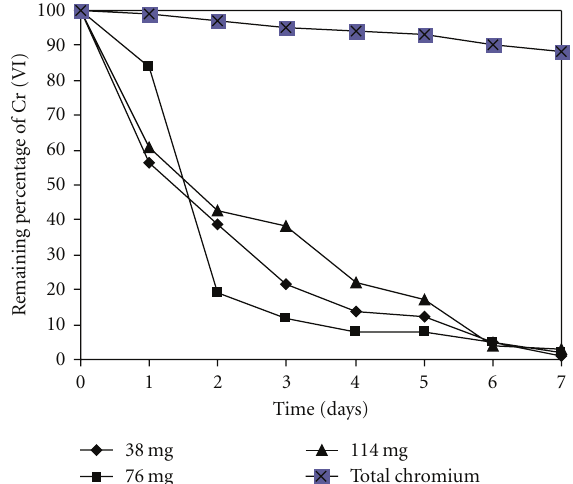
Figure 3: The e ff ect of cell concentration on the removal of Cr (VI). 50mg/LCr(VI). 100 rpm, 28 ◦ C, pH